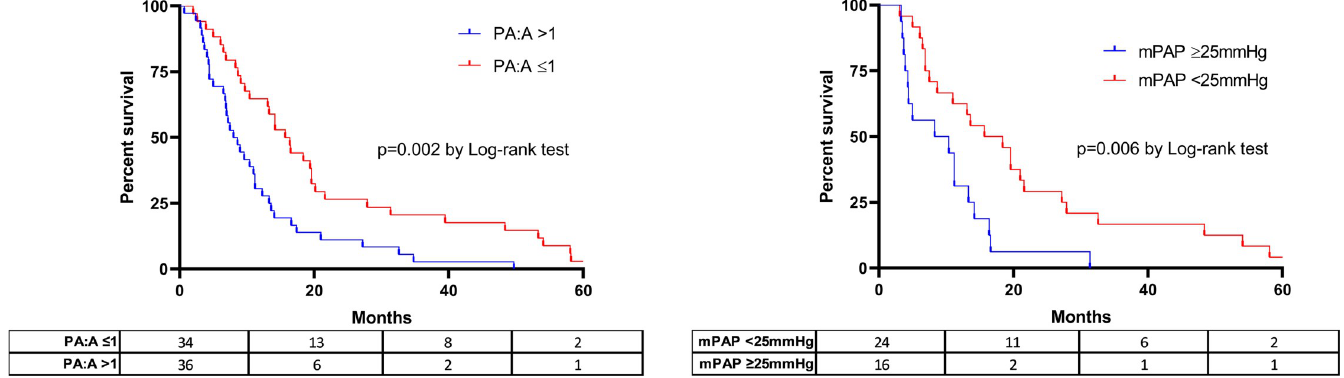
Fig 4. Kaplan-Meier curves for transplant-free survival in severe cystic fibrosis. Survival according to the presence or absence of A) PA:A > 1; or B) mPAP � 25mmHg. The numbers of subjects at risk are displayed below each figure panel. Abbreviations: mPAP = mean pulmonary artery pressure; PA:A = pulmonary artery to ascending aorta diameter ratio; PH = pulmonary